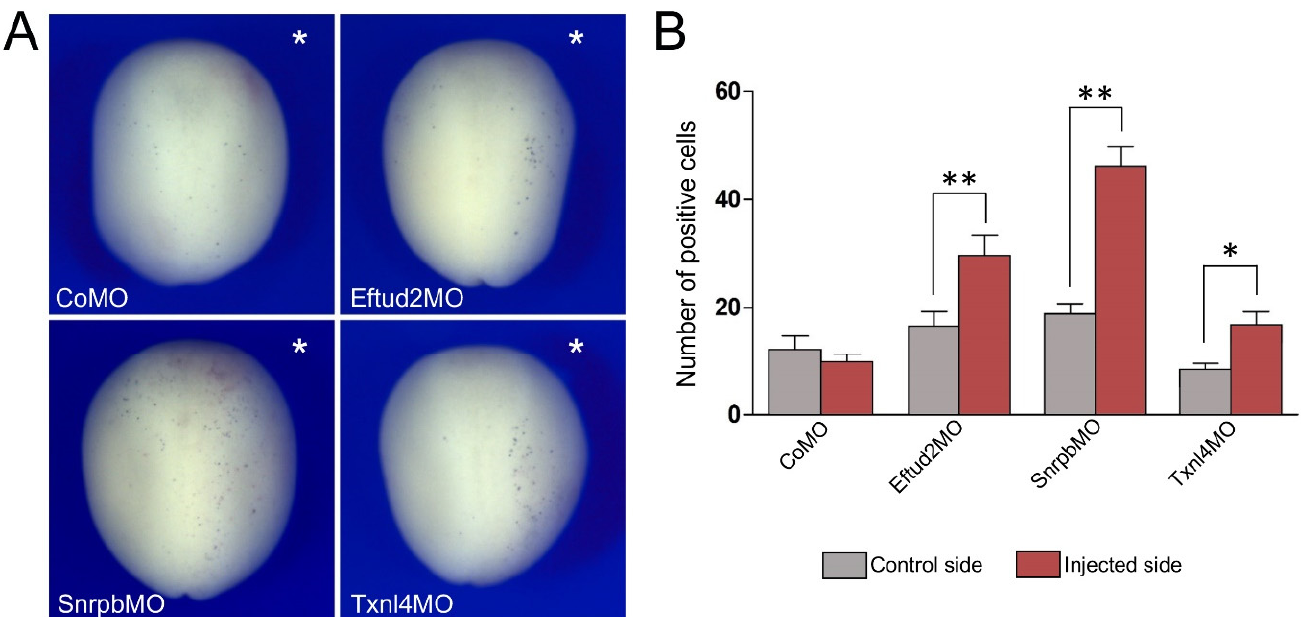
Figure 5. Eftud2, Snrpb and Txnl4a knockdown increase cell death in the ectoderm. ( A ) TUNEL staining of representative morphant embryos at stage 15. The injected side is indicated by an asterisk. Dorsal view, anterior to top. ( B ) Quantification of the number of TUNEL-positive cells in control vs. injected sides of embryos injected with Eftud2MO (n = 33), SnrpbMO (n = 39) and Txnl4MO (n = 41). Values are presented as mean ± s.e.m.; (*) p -value < 0.0005 and (**) p -value < 0.0001 (Student’s t - test).